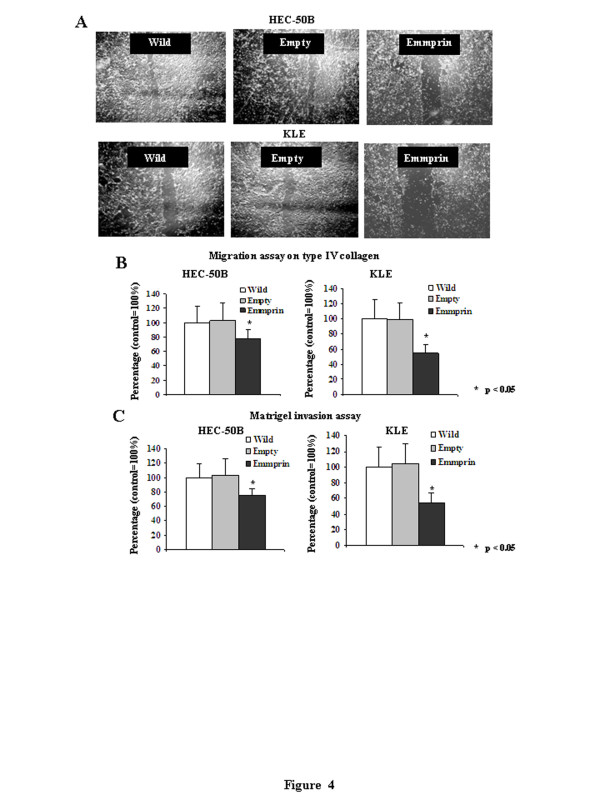
Effects on the motility and matrigel invasion of HEC-50B and KLE cells after transfection with the emmprin siRNA. A) Cell scratch assays of HEC-50B and KLE cells after transfection with the emmprin siRNA for 24 h. B) Migration assays on type IV collagen for HEC-50B and KLE cells after transfection with the emmprin siRNA for 72 h. C) Matrigel invasion assays after transfection of the emmprin siRNA into HEC-50B and KLE cells for 72 h. Following the incubation, the membranes were removed from the inserts and mounted on slides. The numbers of invading cells were counted under a microscope. The motility and Matrigel assays were performed in triplicate.